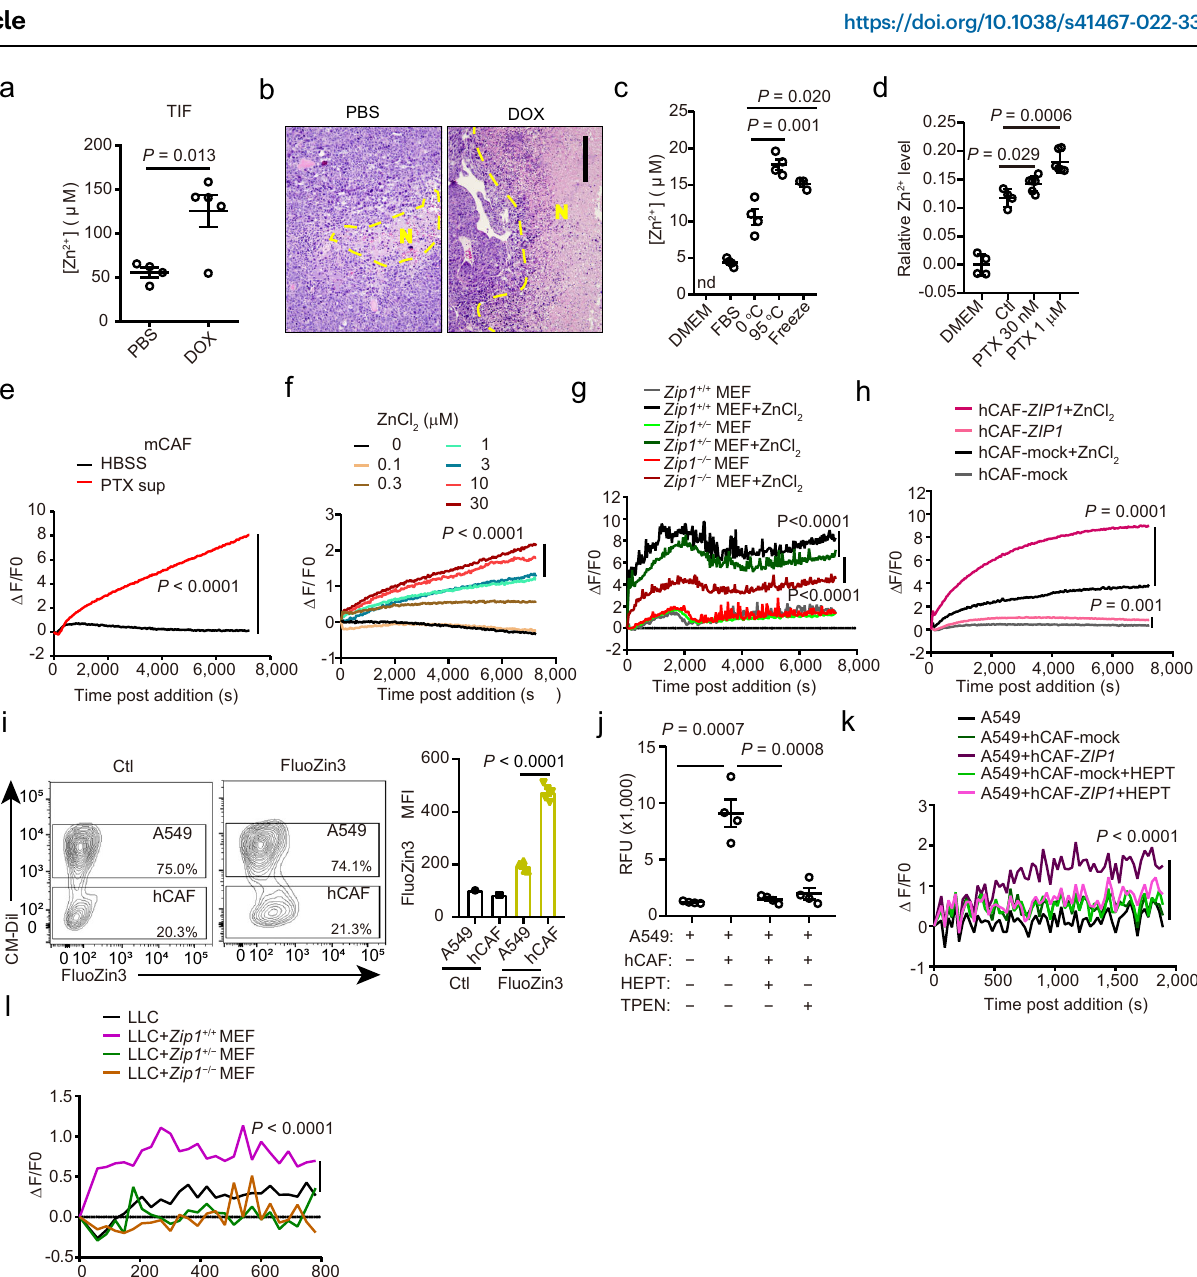
n=3. h Zn 2+ uptake by hCAF-mock or hCAF- ZIP1 . n =3. i Labile Zn 2+ in hCAFs and test for curve comparison. Source data are provided as a Source Data fi le ( a , c – l